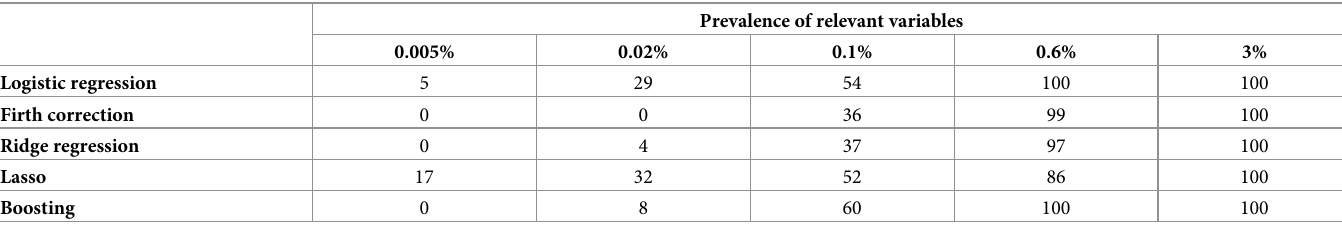
Table 1. CESIR simulation: Selection rates (%) for each of the 5 relevant variables.